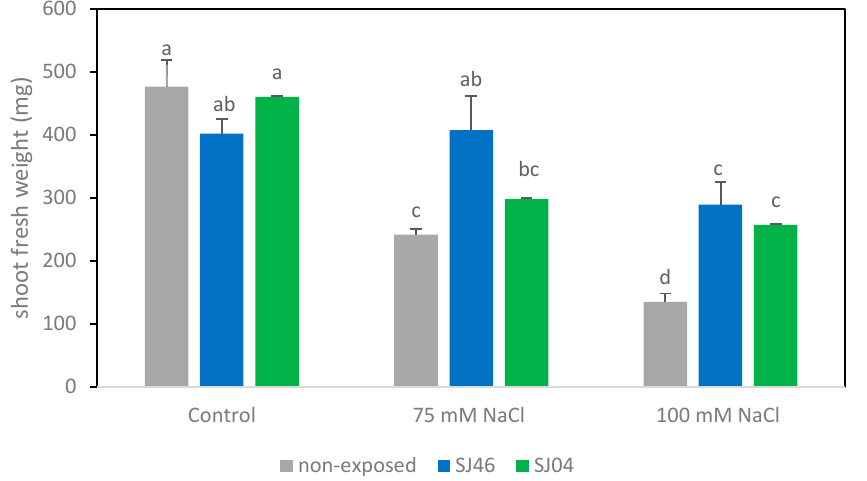
Figure 1. Effects of exposure to SJ46 and SJ04 mVOCs of P. putida on shoot fresh weight of M. piperita plants grown in Murashige–Skoog medium with 0, 75 and 100 mM NaCl. Values are mean ± standard error (SE). Means followed by the same letter in a given column are not significantly different according to Fisher’s LSD test ( p < 0.05).